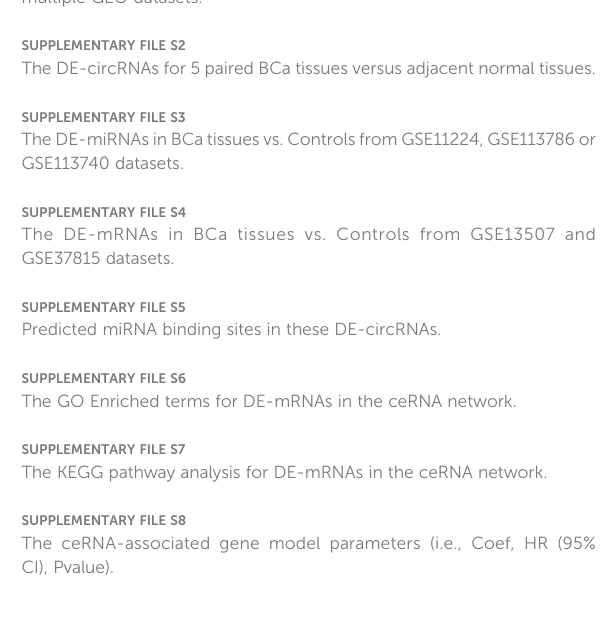
SUPPLEMENTARY FIGURE 1 A correlation between 12 DE-miRNAs and 115 DE-mRNAs form TCGA dataset. (A) The Sankey diagram was plotted according to the correspondence between 12 DE-miRNAs and 115 DE-mRNAs. (B) A correlation analysis of 12 DE-miRNAs and 115 DE-mRNAs expression data. Red lines indicate positive co-expression relationships while blue lines indicate negative co-expression relationships. miRNA, microRNA; differentially expressed-, DE-. SUPPLEMENTARY FIGURE 2 We carried out an immune cell in fi ltration analysis and the ef fi cacy prediction of immunotherapy based on ceRNA-associated gene signature in the test GSE32894 datasets. (A) Heat-mapping demonstrated many signi fi cant differences in immune cell in fi ltration between the high- and low-risk groups. (B, C) Wilcox and chi-square tests were used to assess the association between the ceRNA-associated gene risk signature and clinicopathological features, including the depth of tumor invasion and tumor grade. (D) Based on riskscore, the TIDE algorithm and the expression of immune checkpoint genes were then employed to potentially assess responses to immune checkpoint inhibitor. (E, F) The Spearman correlation between tumor-in fi ltrating immune cells and riskscore.